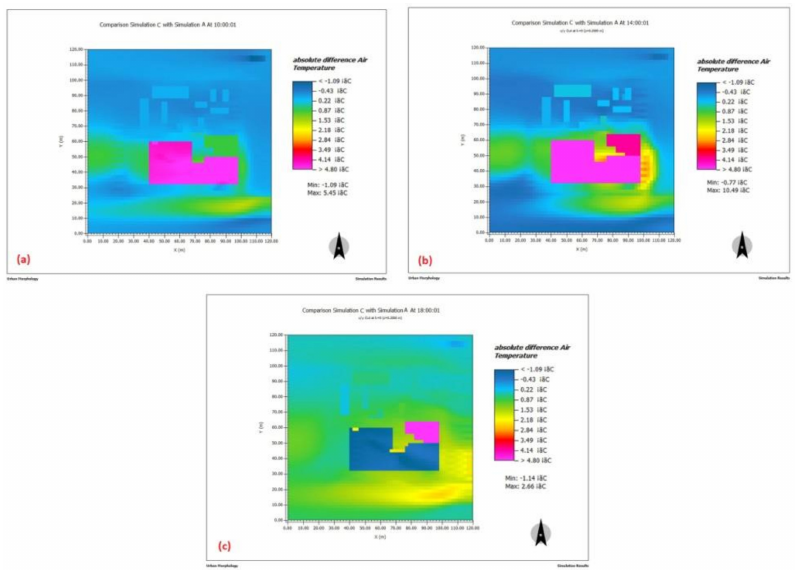
Figure 13. Comparison of differences in T air in the ( a ) morning; ( b ) afternoon; and ( c ) evening.